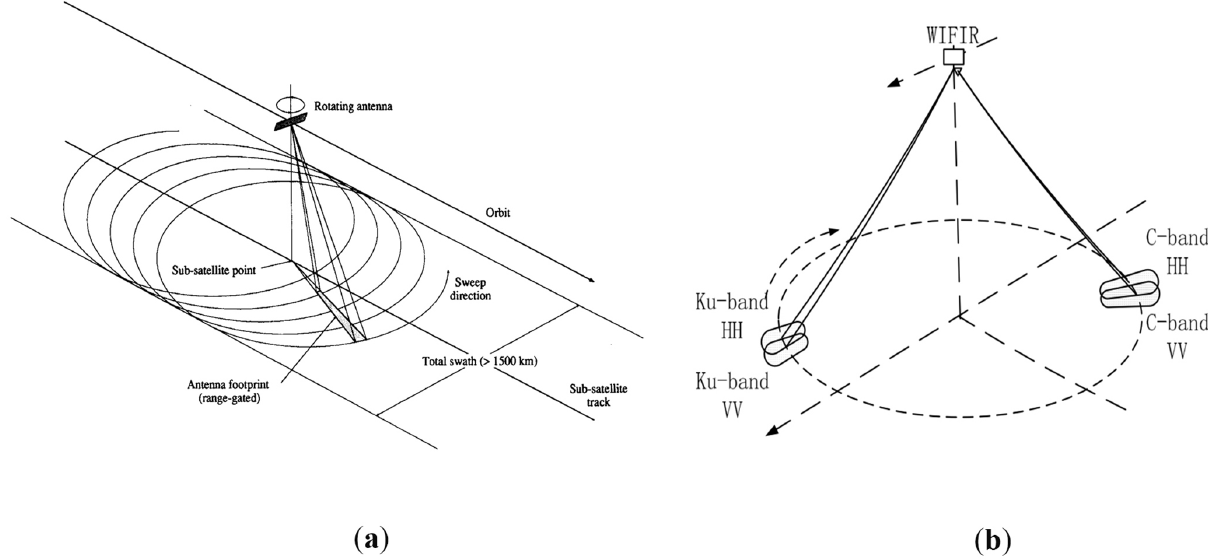
Figure 1. Rotating fan-beam scatterometer. (a) SCAT (Lin et al., 2000a). (b) WindRad (Dou et al., 2014).